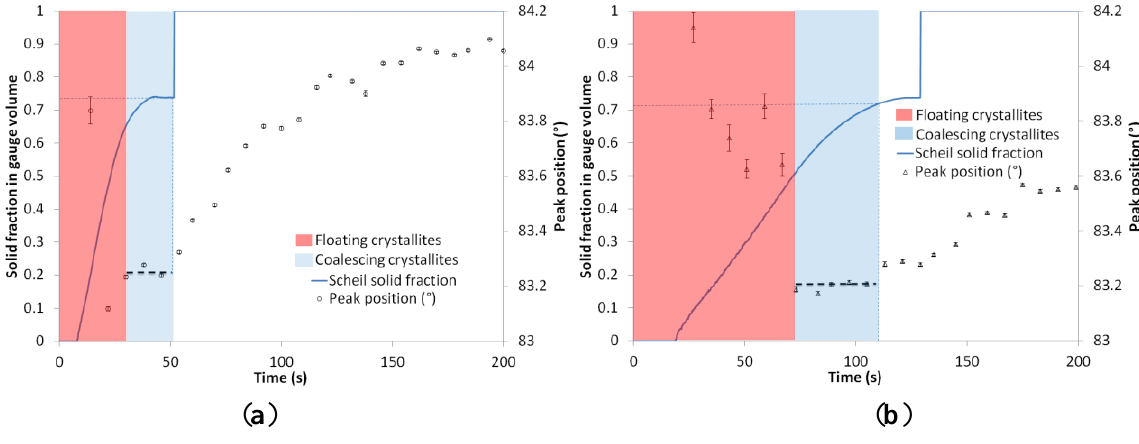
Figure 3. Solid volume fraction in gauge volume and peak position in ( a ) Sample 1; ( b ) Sample